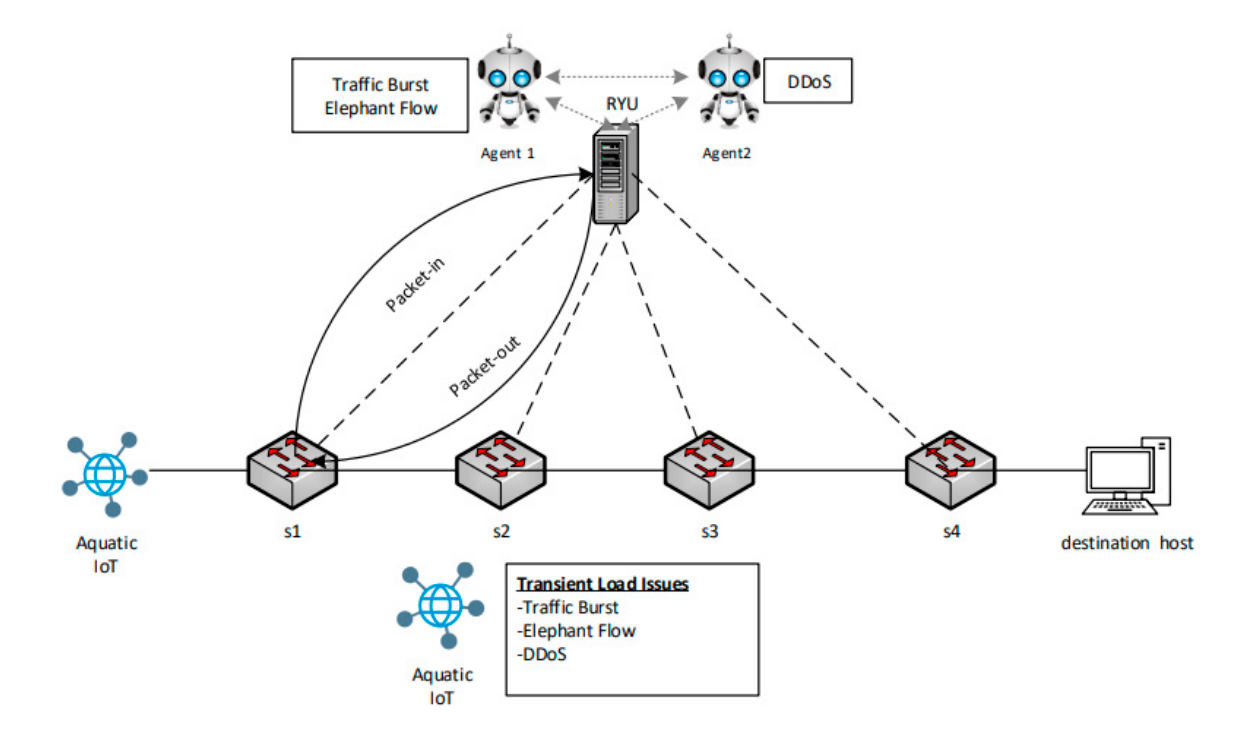
Figure 5. Proposed MARL MADDPG concept.